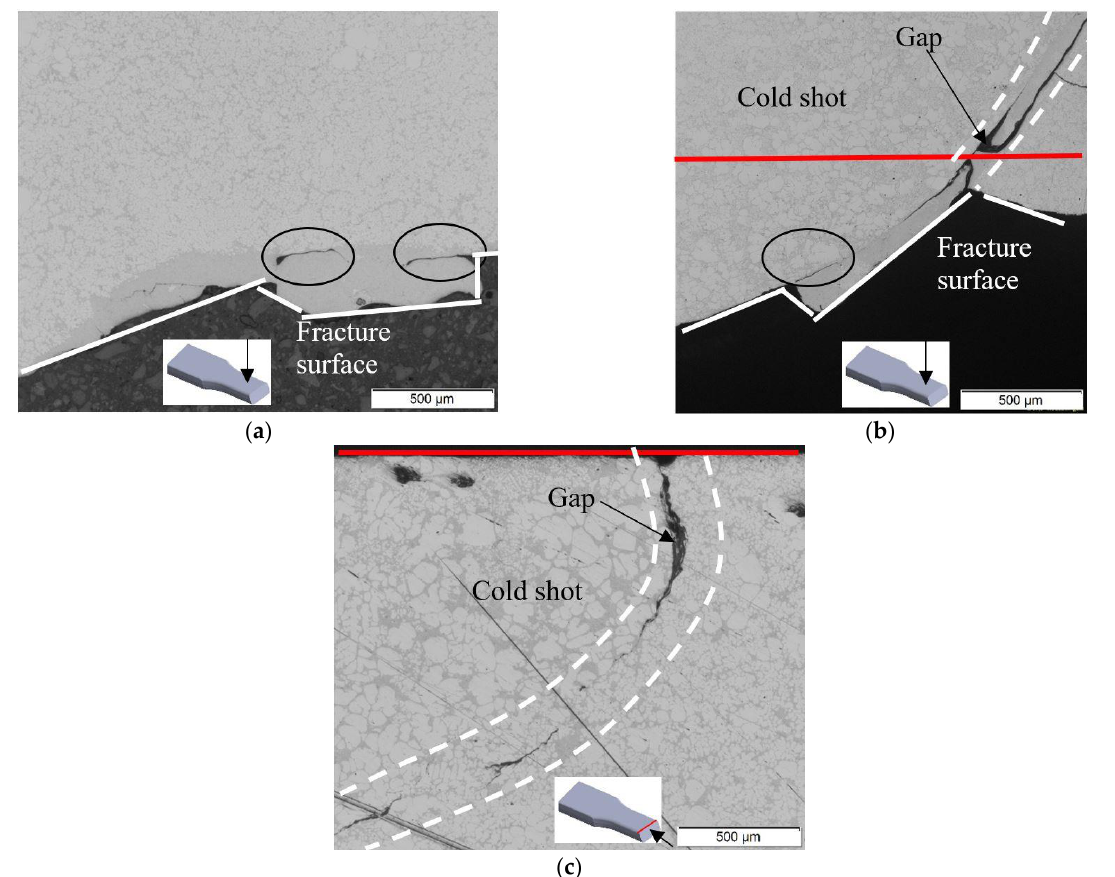
Figure 8. Microstructure of the crack initiation region on the surface perpendicular to the fracture surface of ( a ) SSM Al – 7Si – 0.45Mg in the T5 condition and ( b ) SSM Al – 7Si – 0.6Mg casting in the T5 condition after fatigue testing at σ = ± 158 MPa. ( c ) The microstructure of the surface perpendicular to ( b ) after polishing. The full line shows the fracture surface location in the images. The red line shows the position of the casting surface observed in ( b ). The circles highlight some regions of no bonding.